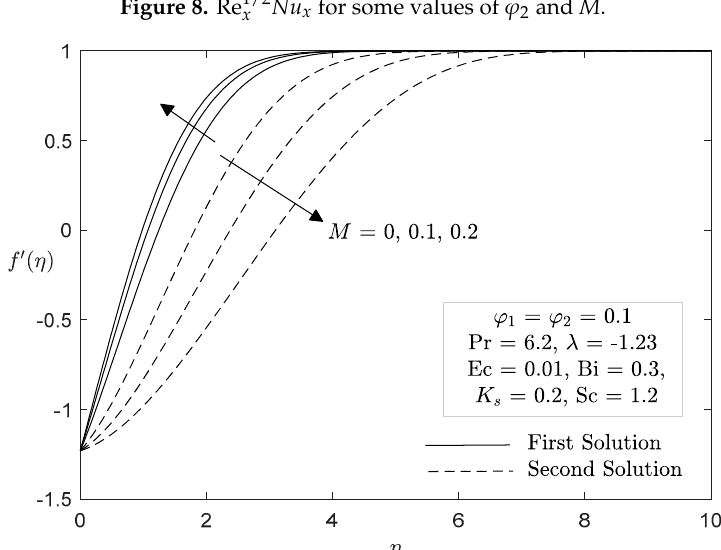
Figure 9. Velocity profile for various values of M .